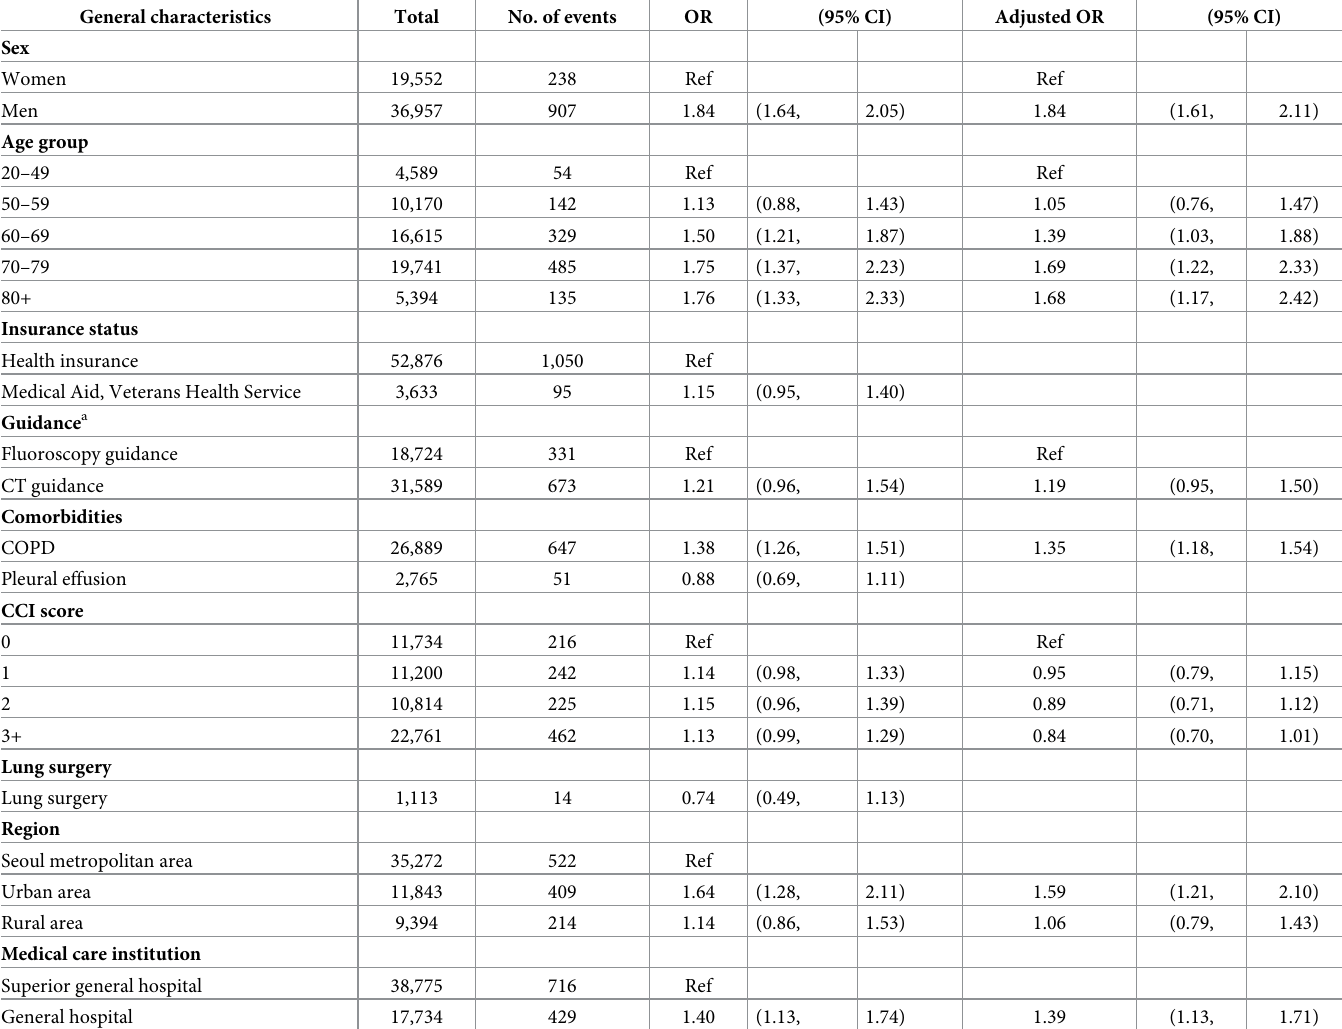
Table 3. Risk of severe pneumothorax associated with patients’